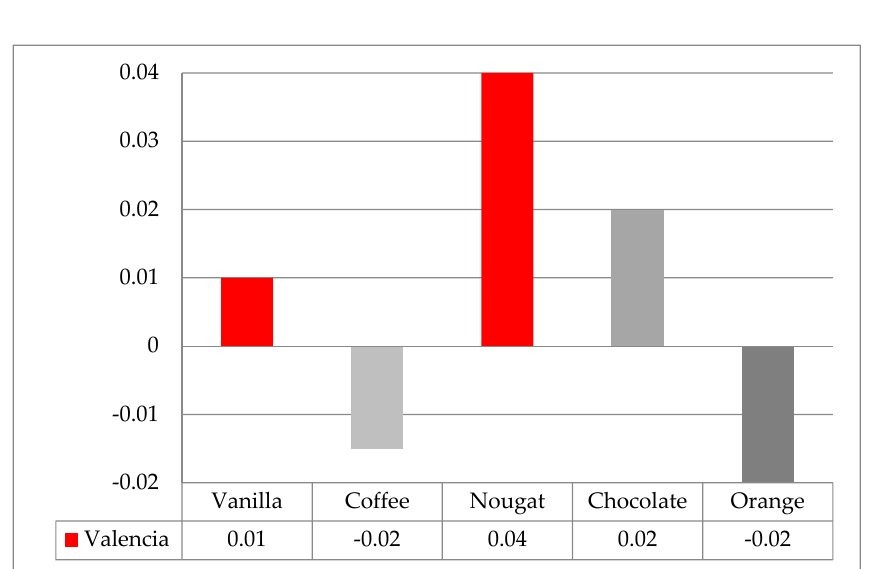
Figure 10. Valence due to tested aromas under laboratory conditions.